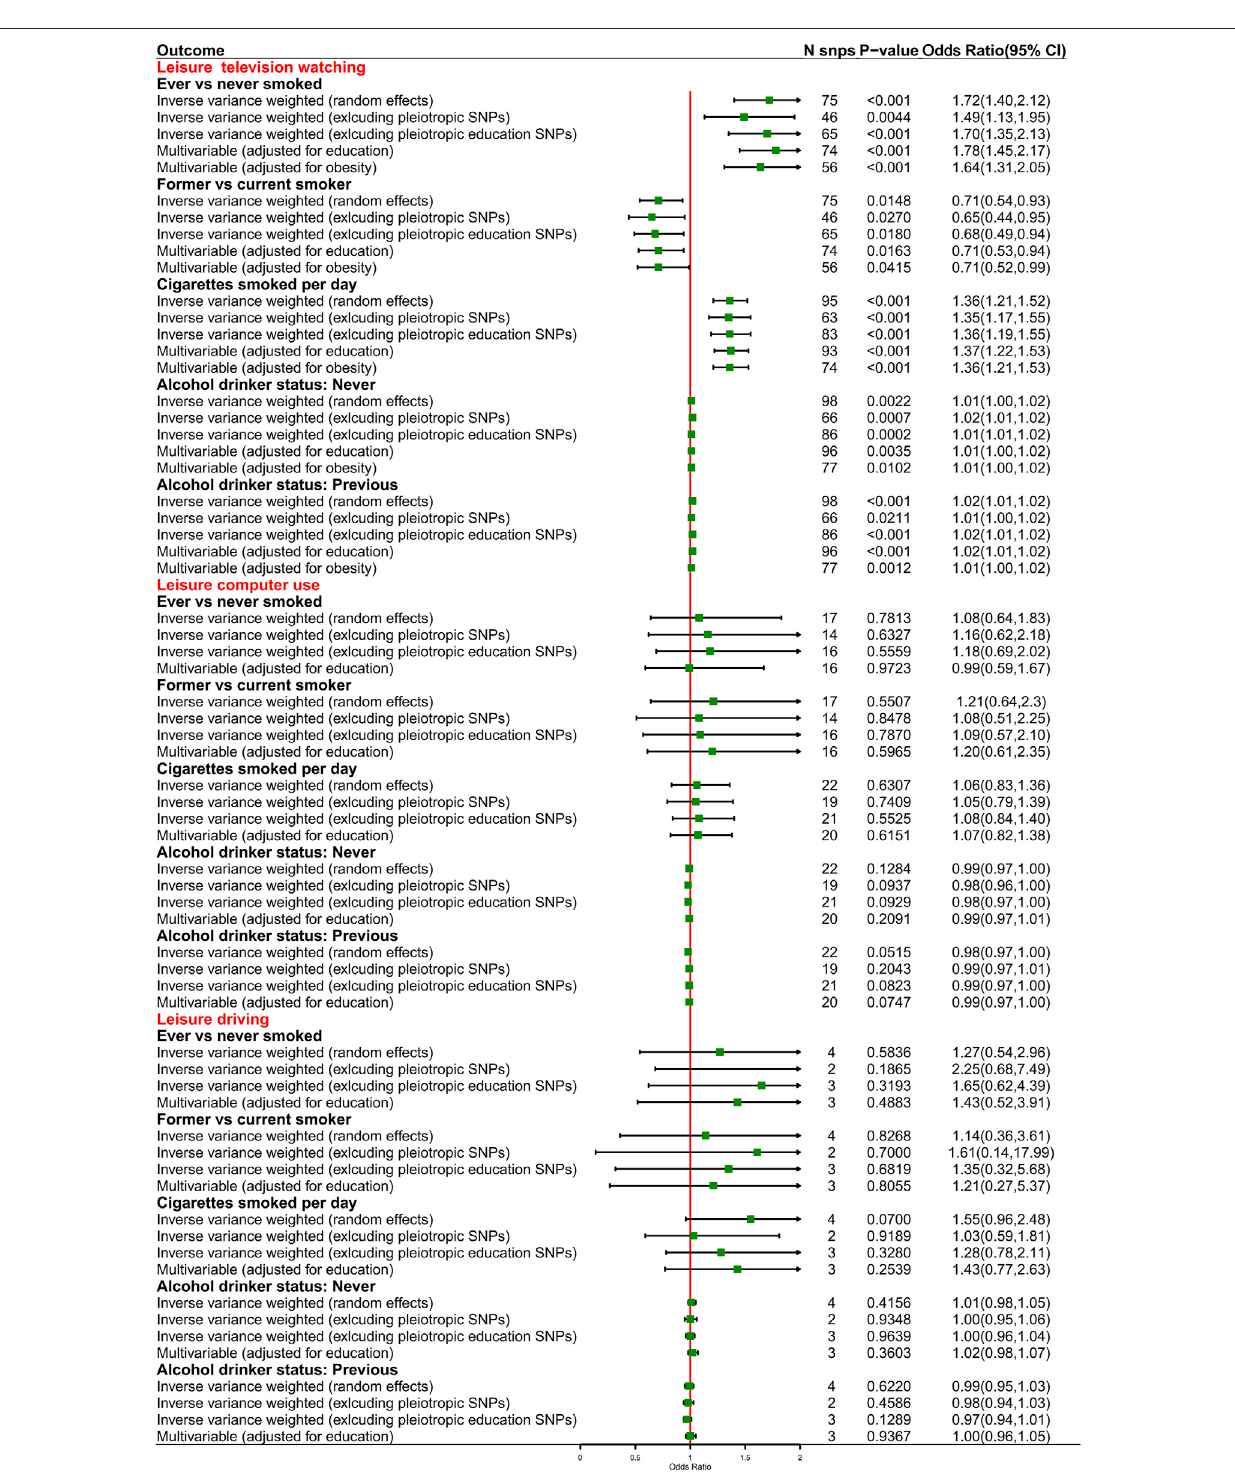
Frontiers in Genetics |